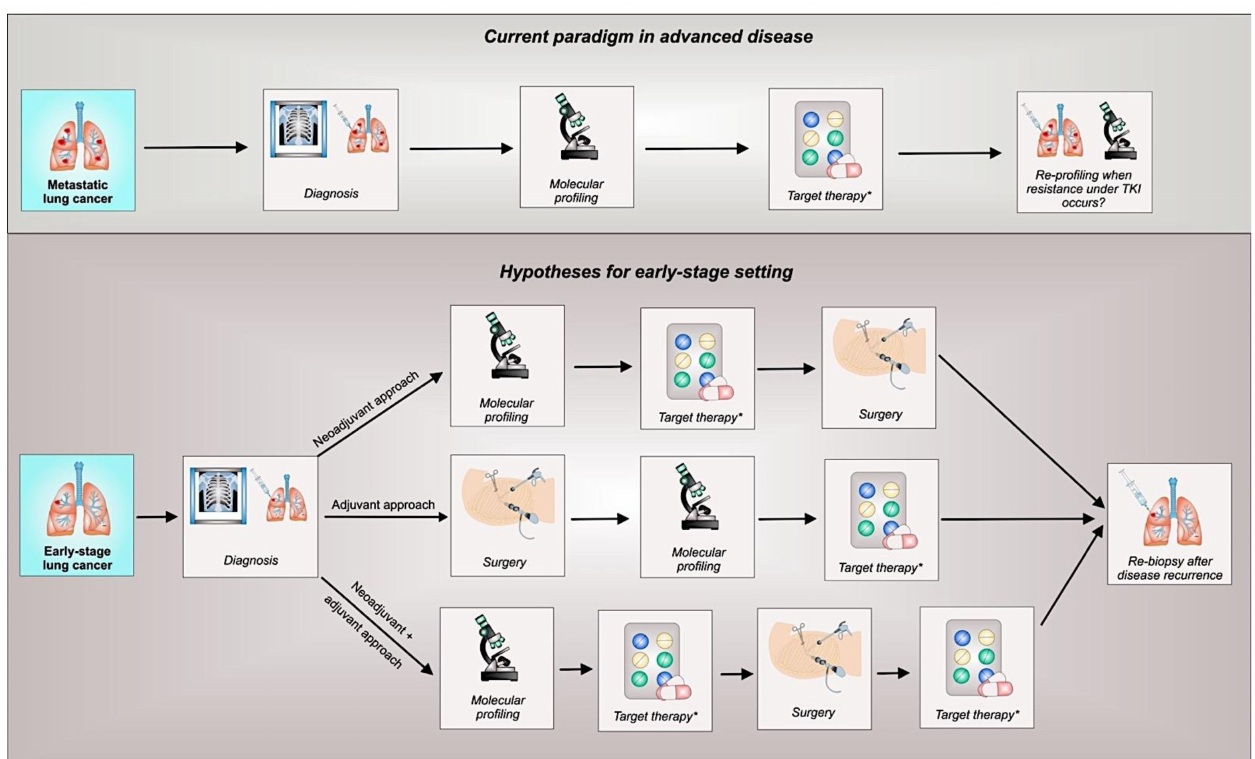
Figure 1. Current paradigm in advanced NSCLC decision-making process and hypotheses for early stage settings. Legend: TKI, tyrosine kinase inhibitor. * Standard of care (i.e., chemotherapy) in the different settings is to be considered according to clinical trials results or current